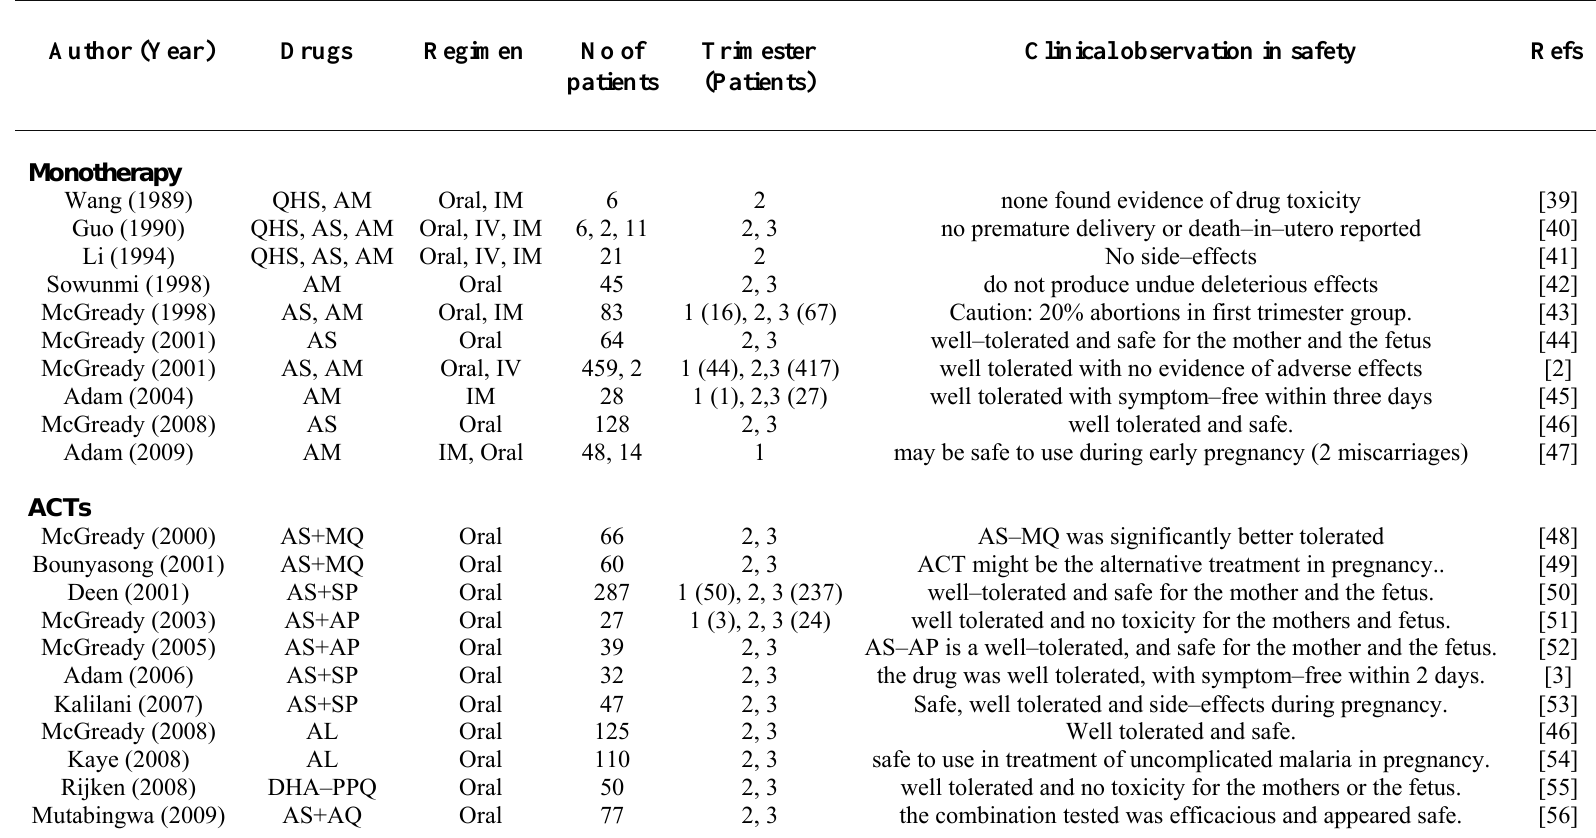
Table 2. Clinical trials and safety evaluation of oral and injectable artemisinins following monotherapy and artemisinin–based combination therapy (ACT) in pregnant women from 1989 to 2009